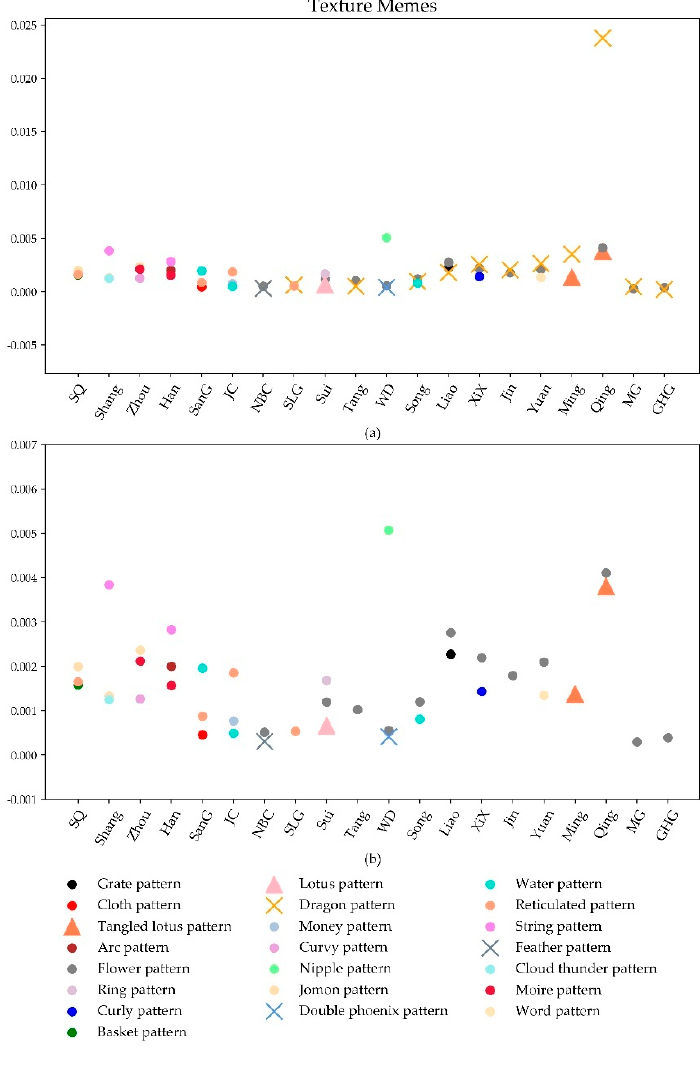
Figure 3. Distribution trend of texture memes. ( a ) Shows the top three texture memes in each dynasty. ( b ) Shows the texture meme except for the dragon pattern.